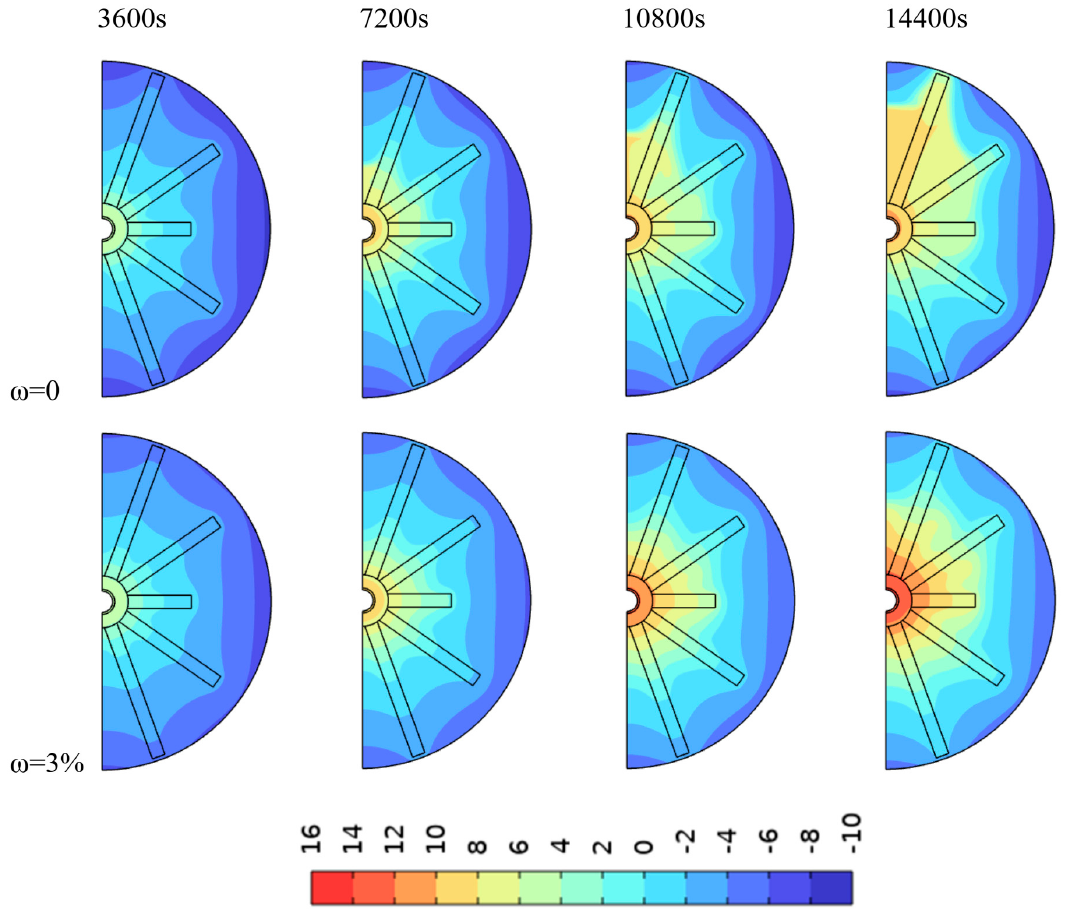
Figure 11. The difference distribution (°C) and T − T f , maps at different time steps for two cases of ω = 0 and ω = 3% wt when ε = 0.95 and δ = 35°.